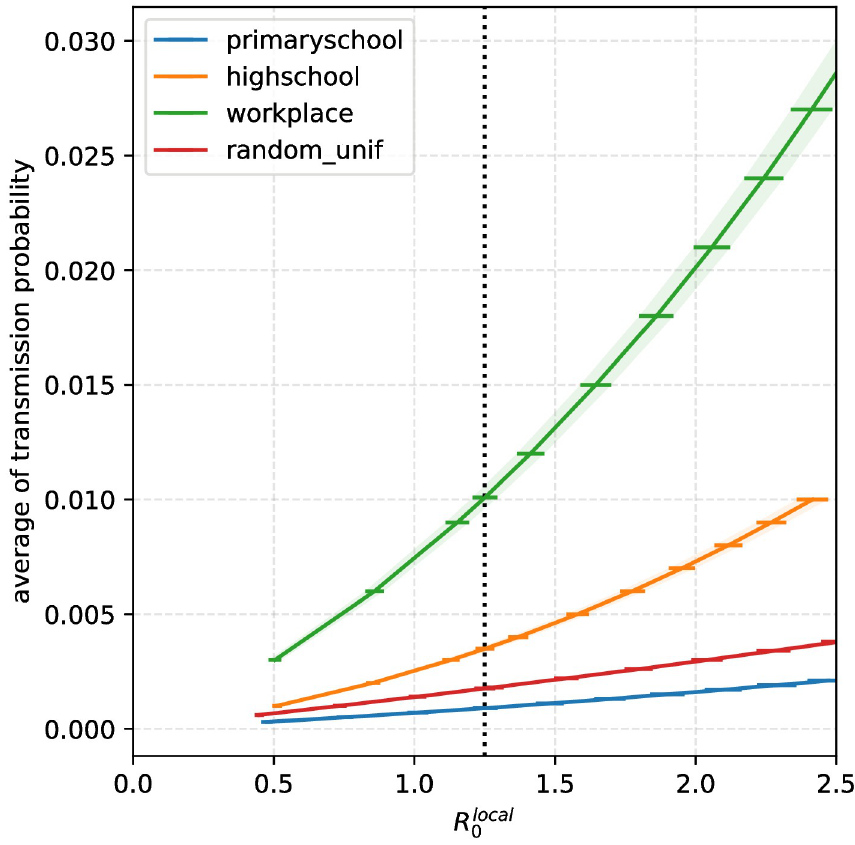
Fig 7. Relation between the baseline transmission parameter p 0 and the network-dependent local reproduction for our four contact networks. We see that each curve is monotone increasing, as expected, but that the number R local 0 dependency is not quite linear.